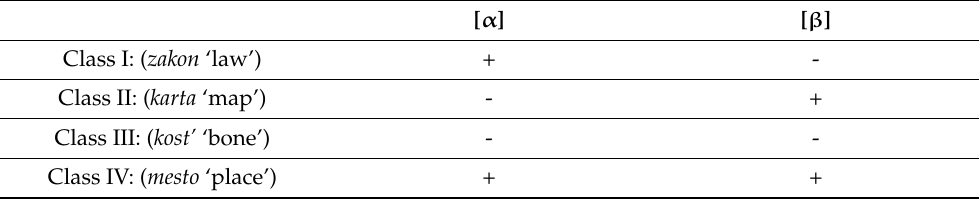
Table 3. Inflectional class features from Müller